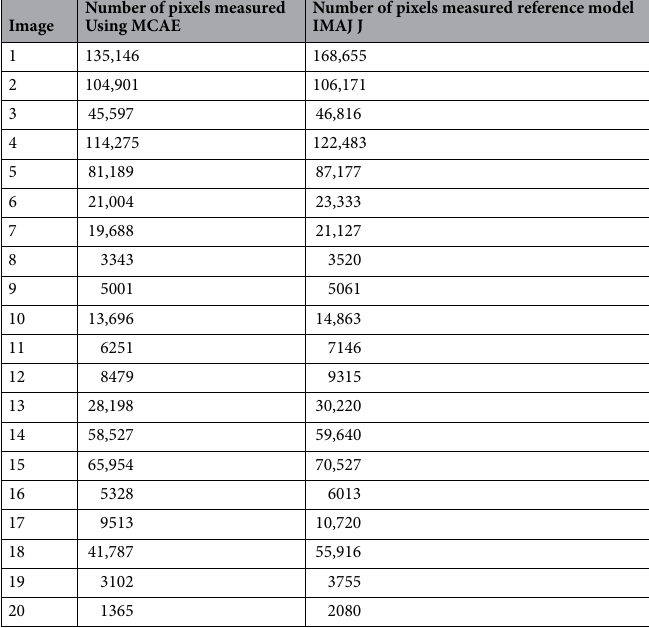
Table 2. Summary of accuracy measurement between our proposed approach MCAE and IMAJ J.